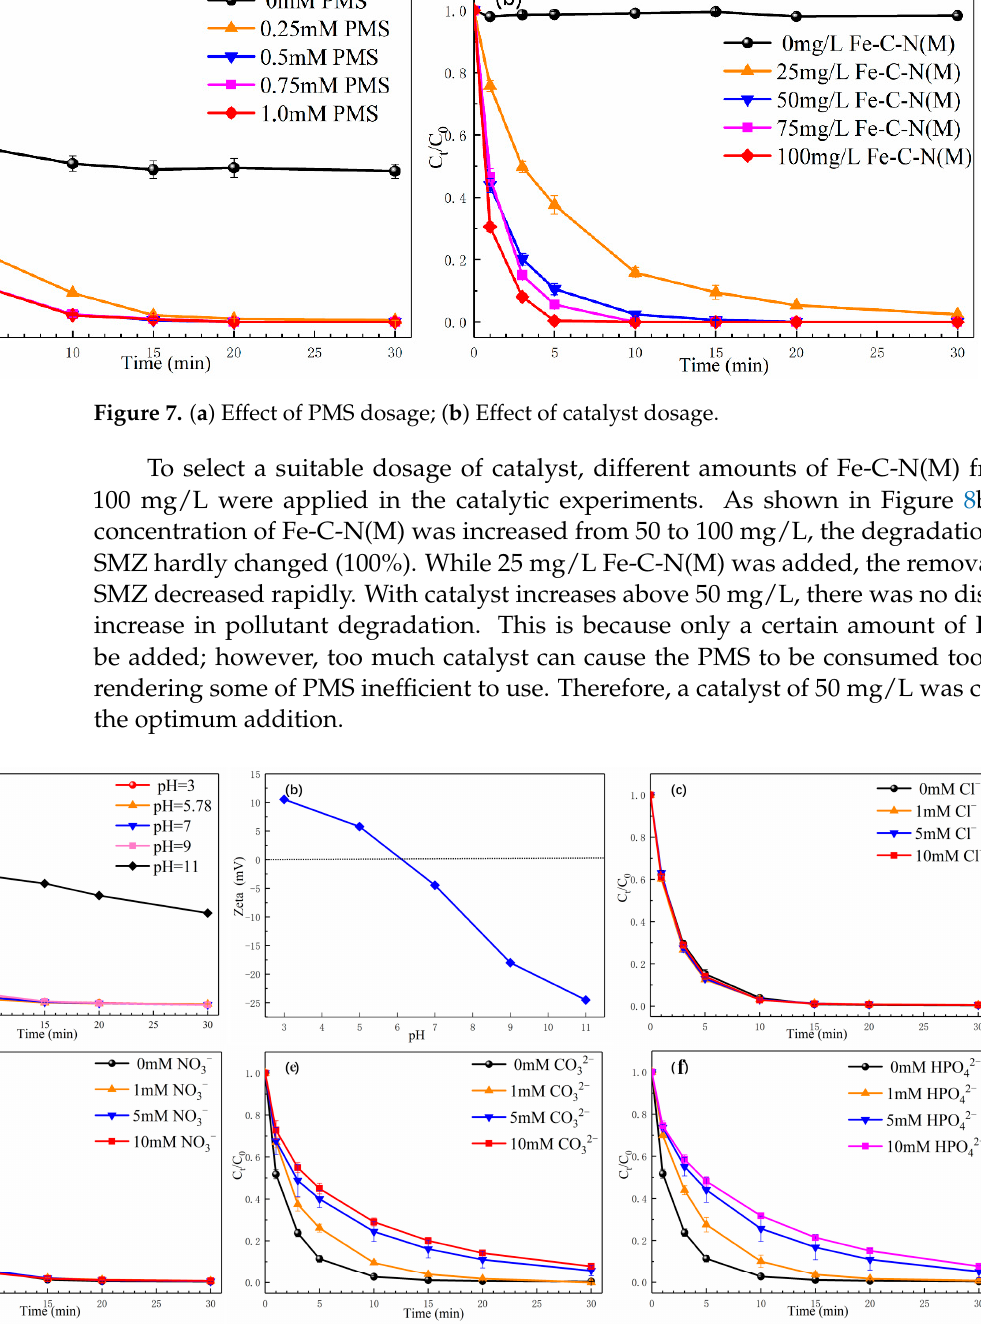
Figure 8. ( a ) Effect of pH; ( b )Zeta potentials at different pH values; Effect of ions on degradation of SMZ: ( c ) Cl − , ( d ) NO 3 − , ( e ) CO 3 2 − , ( f ) HPO 4 2 − . Reaction conditions: SMZ = 5 mg/L, catalyst = 50 mg/L, pH = 5.78.